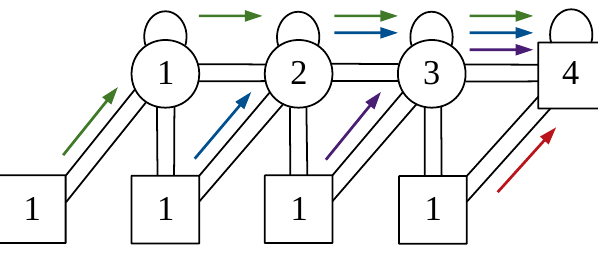
Figure 7 . Diagrammatic representation of the operators in the (cid:12)rst row of the matrix M . Arrows of the same color represent chiral (cid:12)elds that we assemble to construct an element of the matrix. In order to have a gauge invariant operator, we have to consider sequences of arrows that start and end on a squared node. In this case, this is achieved starting with one diagonal (cid:13)avor, going along the tail with an arbitrary number of bifundamentals and ending on a vertical (cid:13)avor.